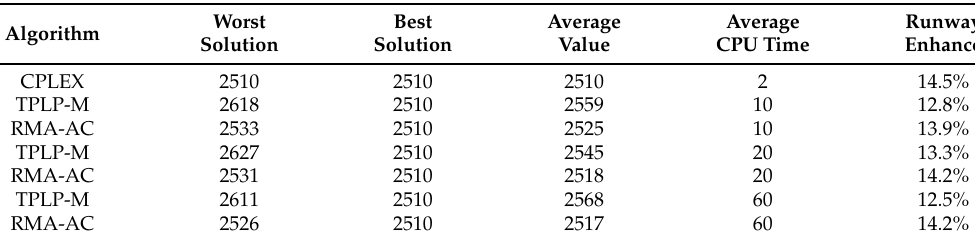
Table 3. Solution quality of RMA-AC, TPLP-M and CPLEX with the time limit of 20 s.